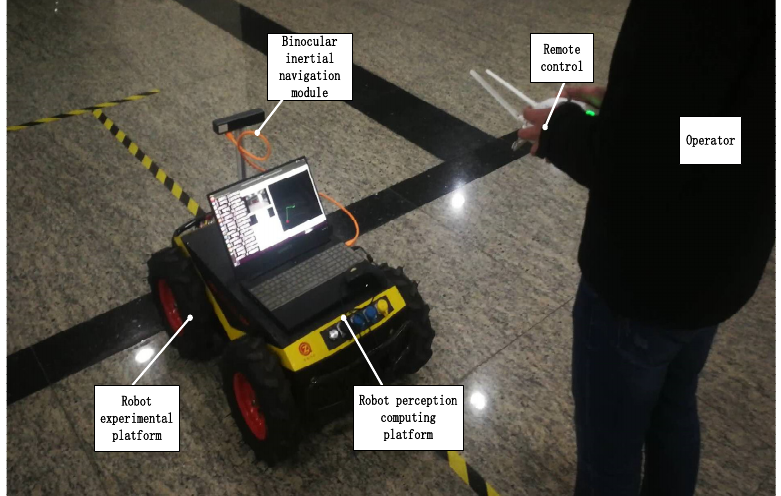
Figure 1. Hardware framework of robot.